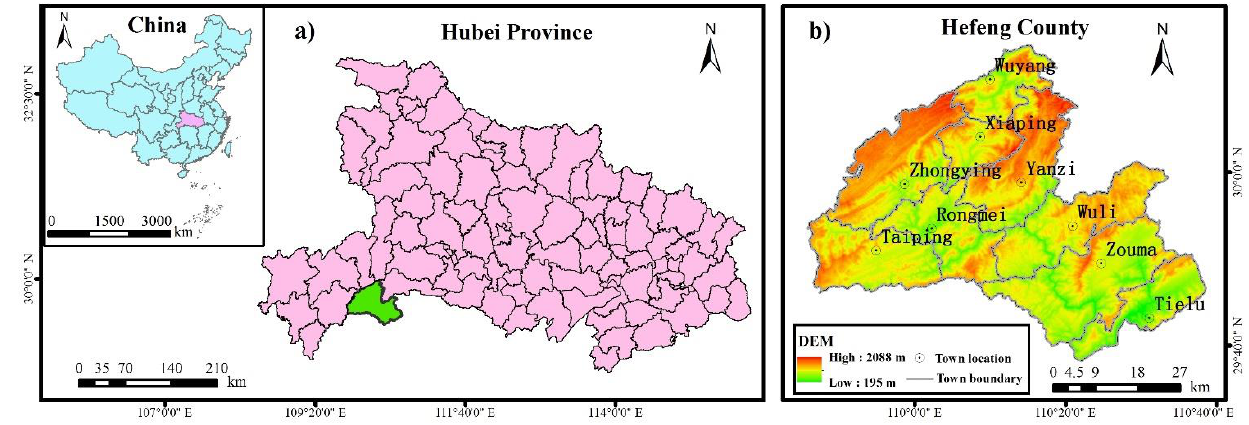
Figure 1. Study area: ( a ) location of Hefeng County in the Hubei Province, China; ( b ) digital elevation map (DEM) of Hefeng County.